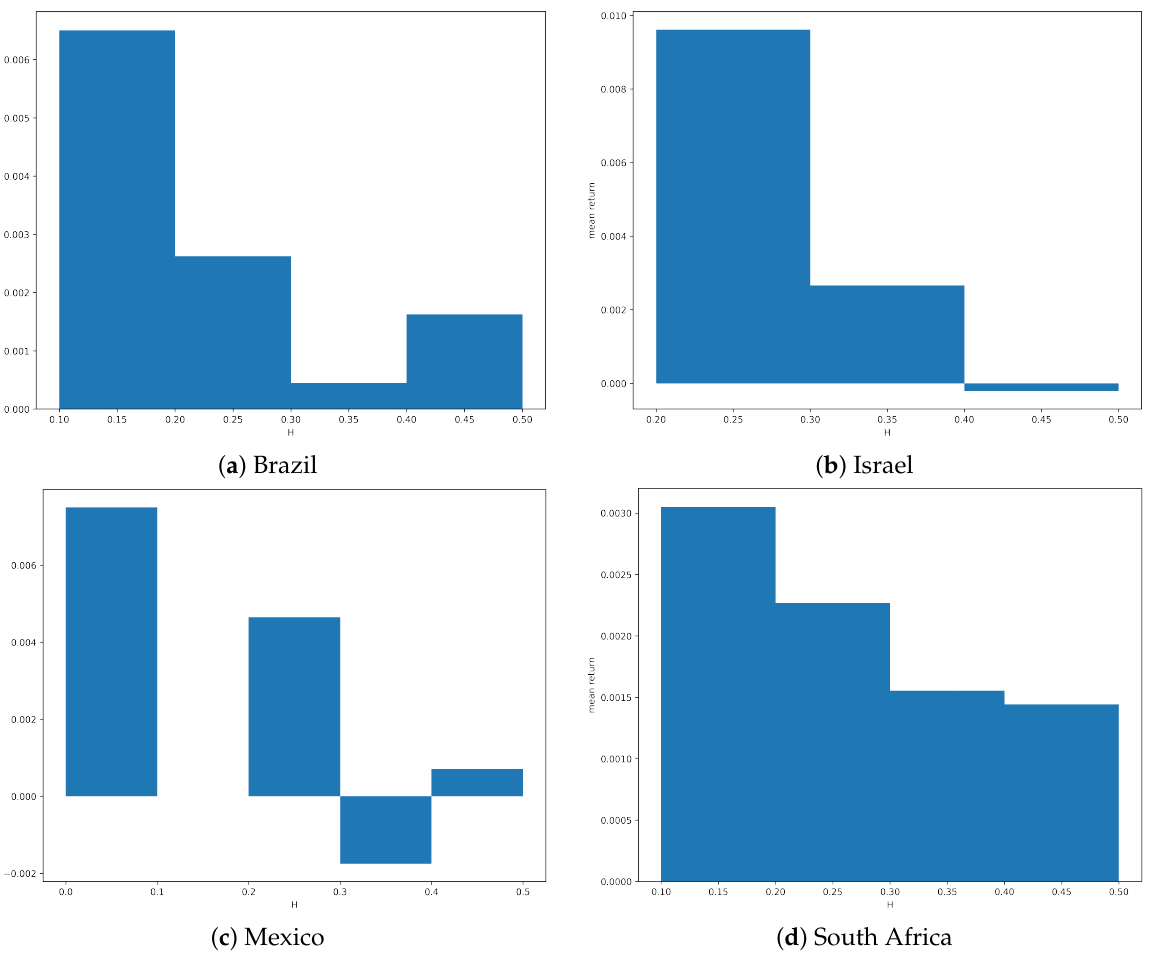
Figure 5. Comparison between the value of H and the mean return between countries for the period